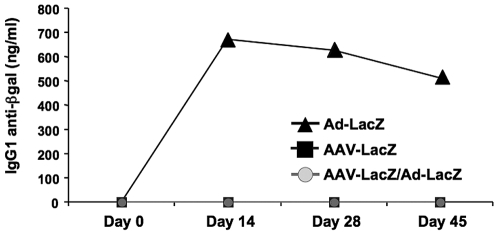
Antibody formation against β-gal.Graphed are β-gal-specific IgG1 titers as a function of time after Ad-lacZ gene transfer in AAV-LacZ/Ad-LacZ and Ad-LacZ only transduced mice and, for comparison, in AAV-LacZ only mice. Data are average±SD for n = 4 mice/experimental group.